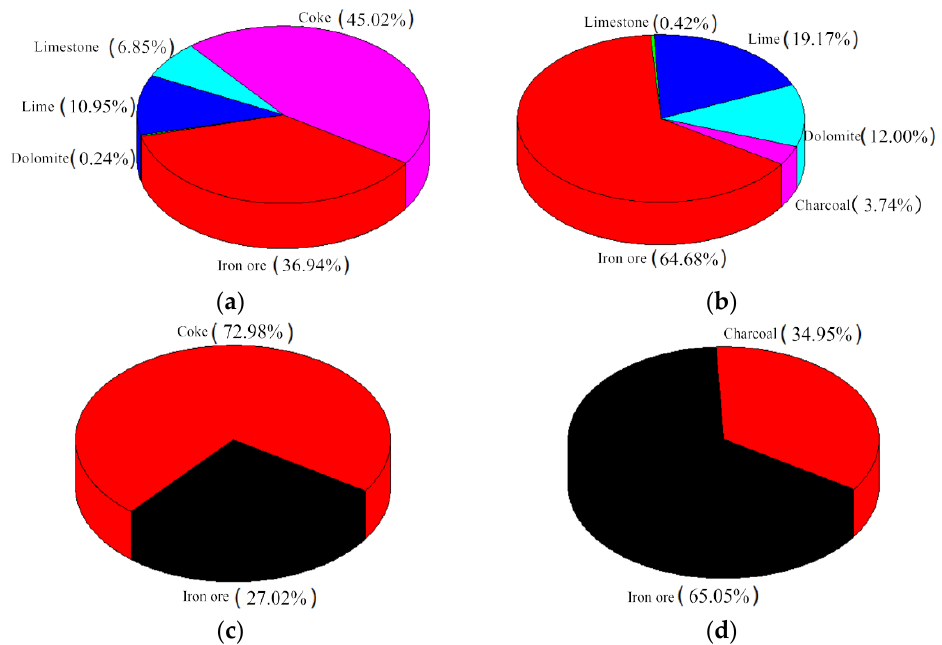
Figure 1. S and N content in sintering raw materials. ( a ) S content of coke in sintering raw materials. ( b ) S content of charcoal in sintering raw materials. ( c ) N content of coke in sintering raw materials ( d ) N content of charcoal in sintering raw materials.